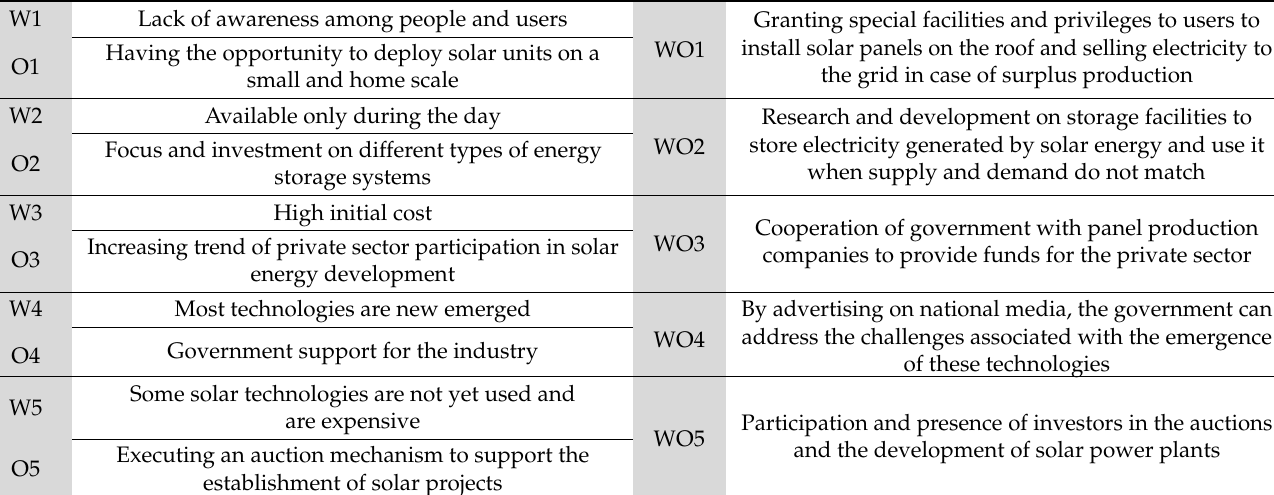
Table 2. WO arrays of the matrix.